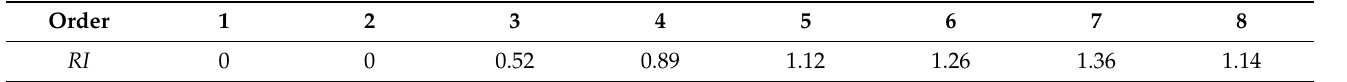
Table 3. Evaluation of random consistency index assignment